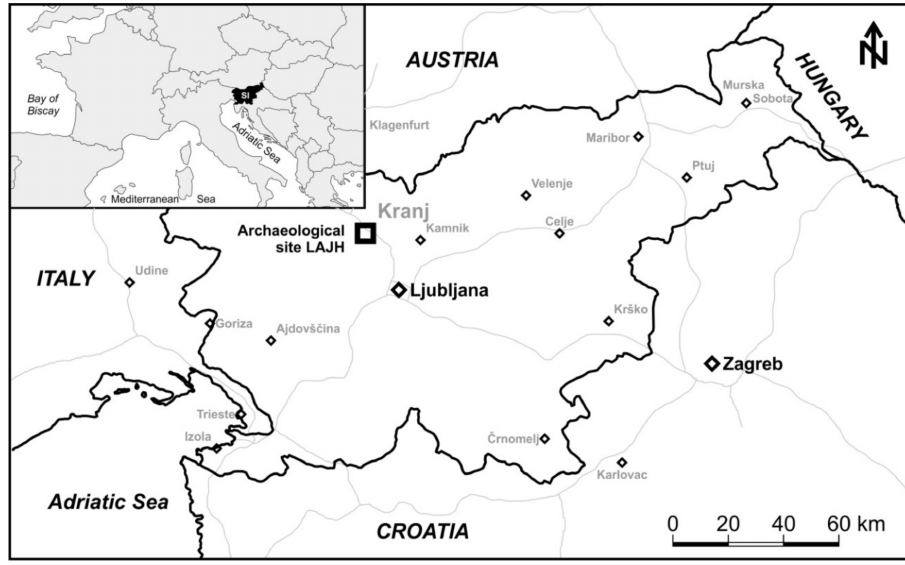
Figure 1. Archaeological site Lajh in city of Kranj in